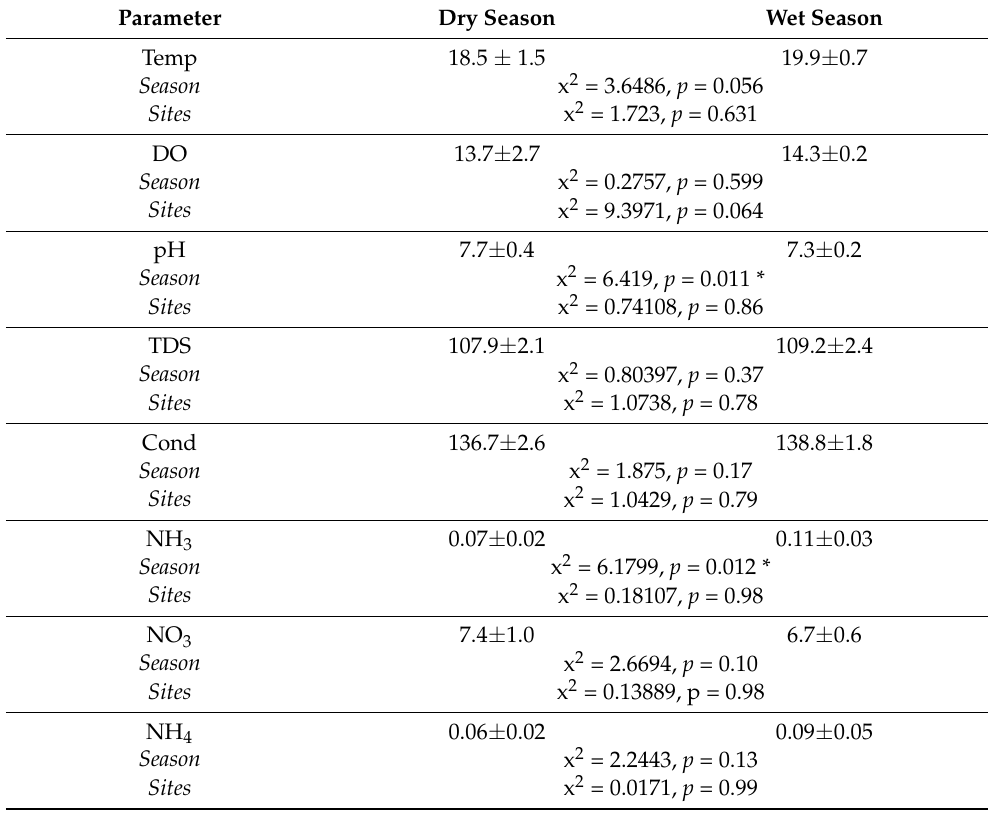
Physical and chemical water characteristics of Lake Zacapu, Michoac á n, Mexico. Temp = water temperature ( ◦ C), DO = dissolved oxygen (O 2 mg/L), pH = potential for hydro- gen, TDS = total dissolved solids (mg/L), Cond = conductivity ( µ S/cm), NH 3 = ammonia (mg/L), NO 3 = nitrate (mg/L), NH 4 = ammonium (mg/L). Average and standard deviation (¯X ± SD). Kruskal Wallis differences among seasons and sites. * Significant